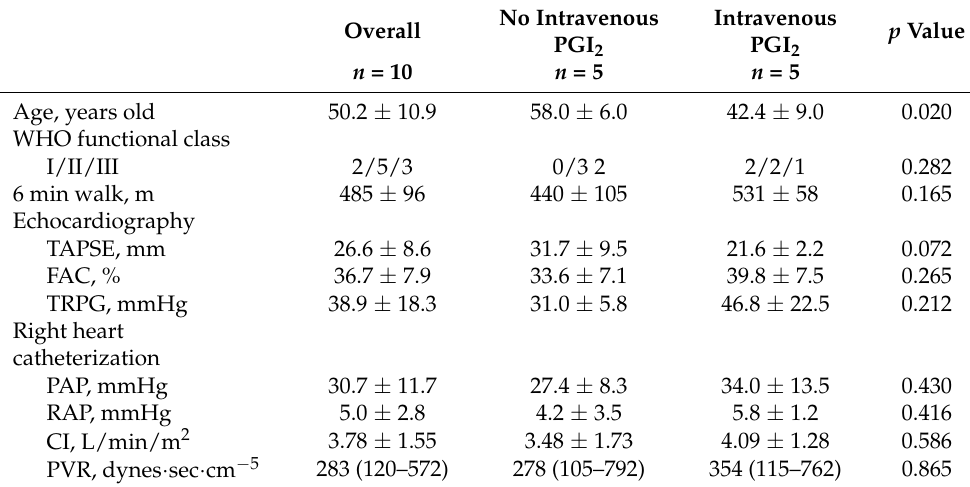
Table 2. Comparison between with and without intravenous